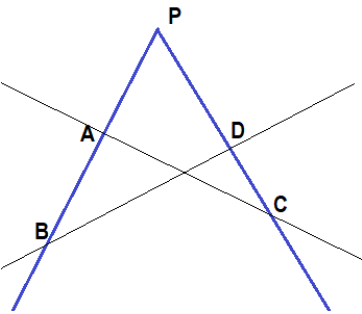
Figure 1. The meaning of Veblen-Young Axiom.